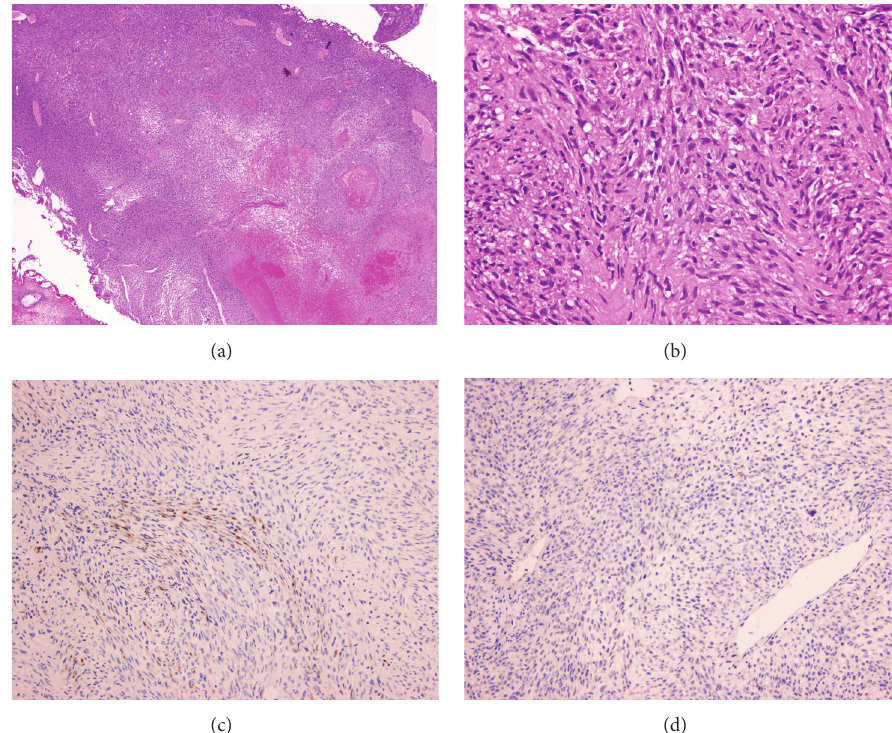
Figure 2: Microscopic findings of the transurethral resection biopsy specimen. (a) Low-power view shows spindle cells arranged in tightly packed fascicles, with alternating hypo- and hypercellular areas and geographic necrosis (H&E stain, × 40). (b) High-power view shows spindle-shaped tumor cells with hyperchromatic nuclei and frequent mitoses. Some entrapped prostatic glands are also seen (H&E stain, × 400). (c) By immunohistochemistry, the tumor cells demonstrate focal immunopositivity of S-100 protein (Immunoperoxidase, × 200) and (d) no immunoreactivity with CDK4 (Immunoperoxidase, ×